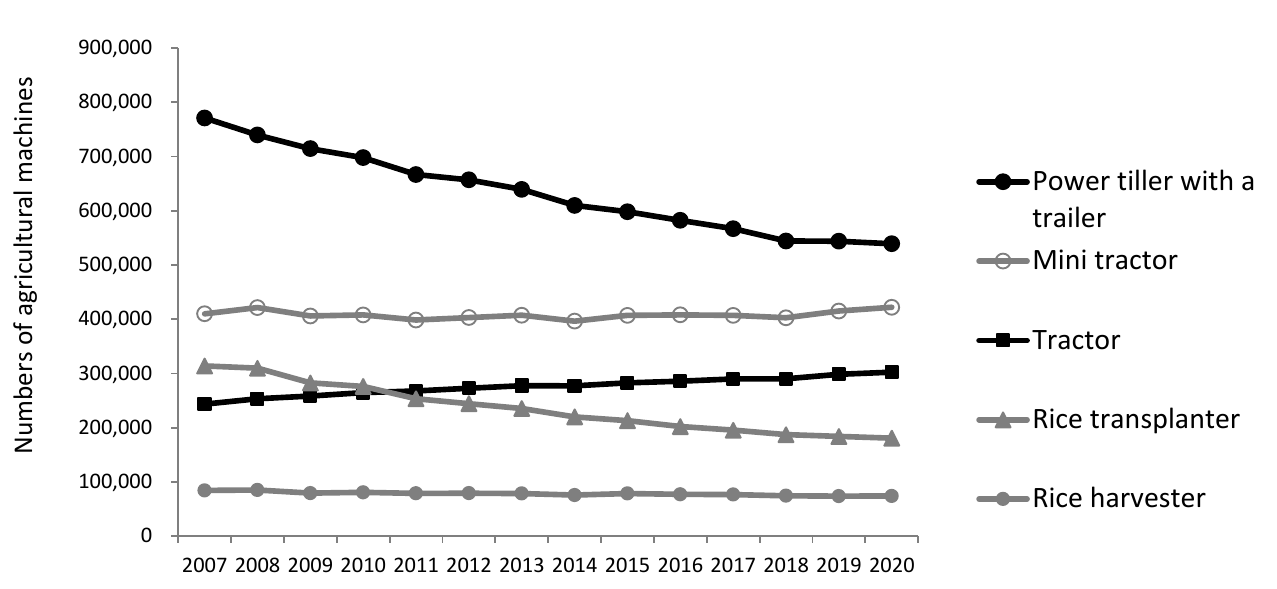
Figure 1. Number of agricultural machines in South Korea.